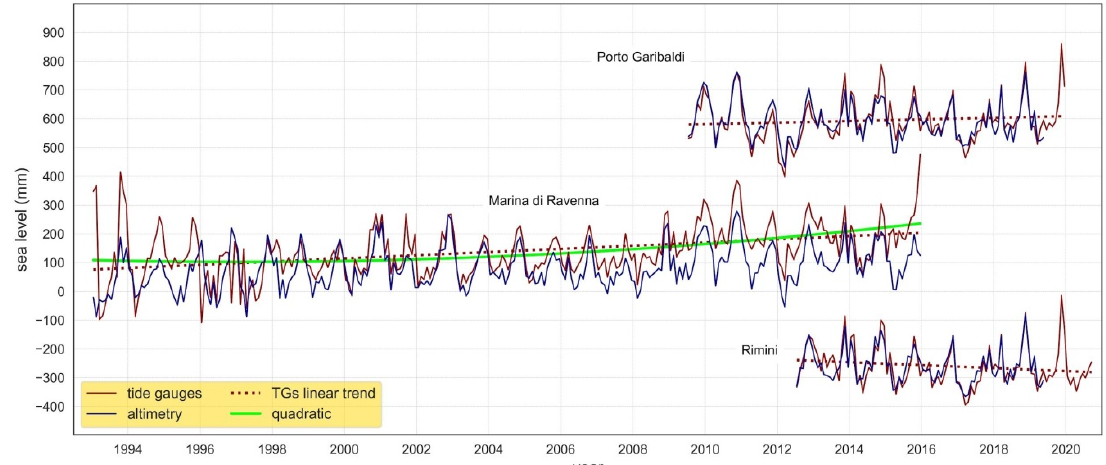
Figure 3. The three TG time series (IB-corrected) compared with their SA closest grid point data. Associated TGs linear and quadratic models are represented by dotted and solid lines, respectively, and their values summarized in Table 2. The time series are displayed with random offsets for readability purposes. Table 2. Linear trend rate (for raw data and IB-corrected data) for the tide gauges considered in this work. The significance of the resulting trend varies according to the symbol beside each